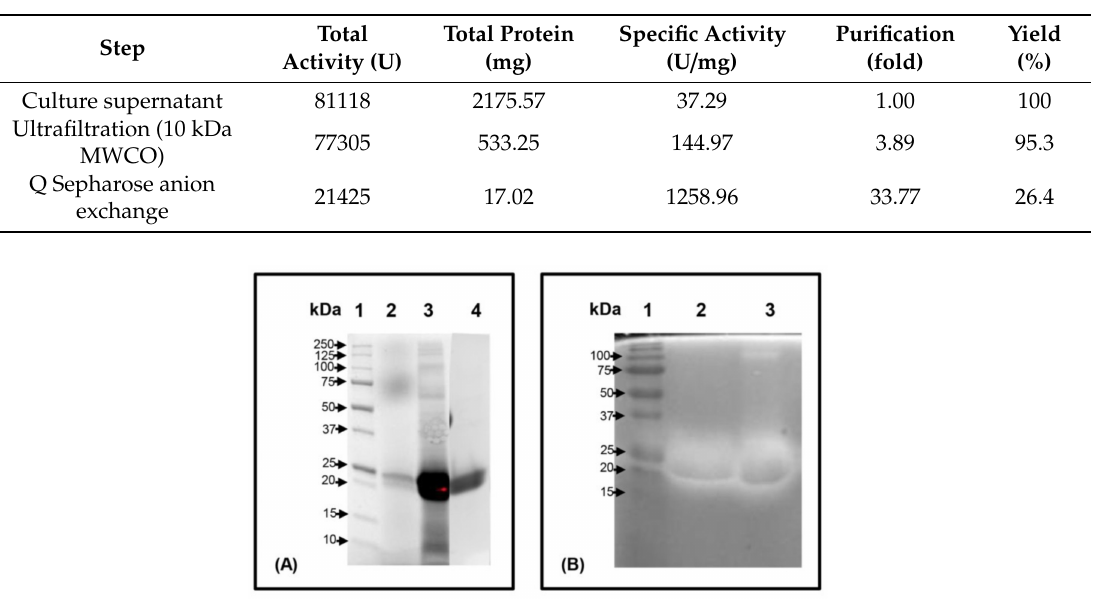
Figure 2. SDS-PAGE analysis and zymography of Pc Xyn11A produced in P. pastoris X-33. ( A : SDS- PAGE), ( B : Zymogram of xylanase). Lane 1: Molecular weights of the markers, Lane 2: